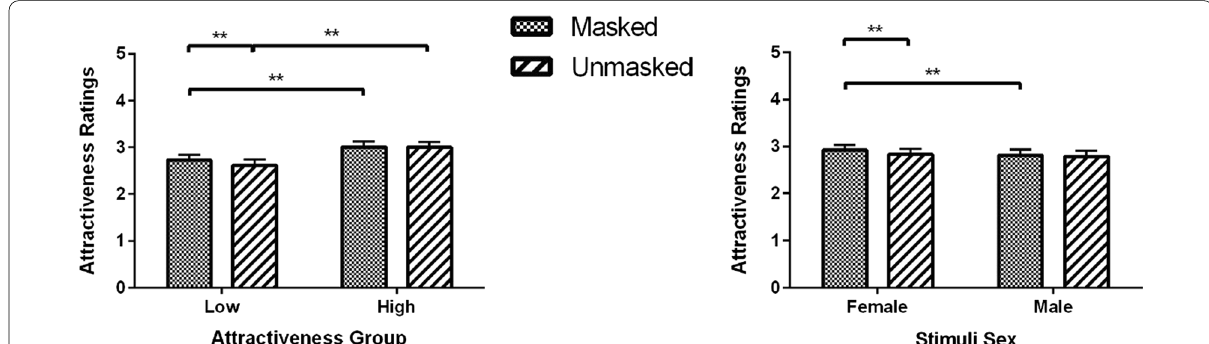
Fig. 4 Attractiveness ratings (Means and SEM) for masked and unmasked old faces as a function of attractiveness group and stimuli sex. * p < 0.05, ** p <